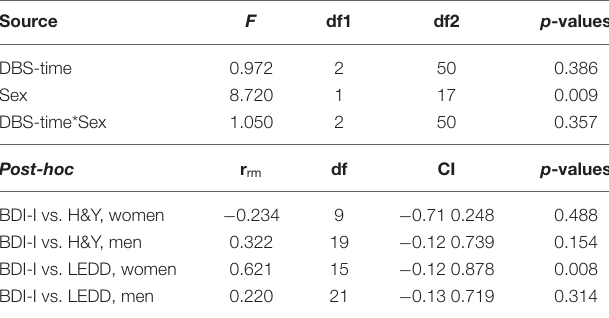
TABLE 3 | Fixed effects of the generalized linear mixed model and post-hoc repeated measures correlations for the BDI-I scores. Source p -values